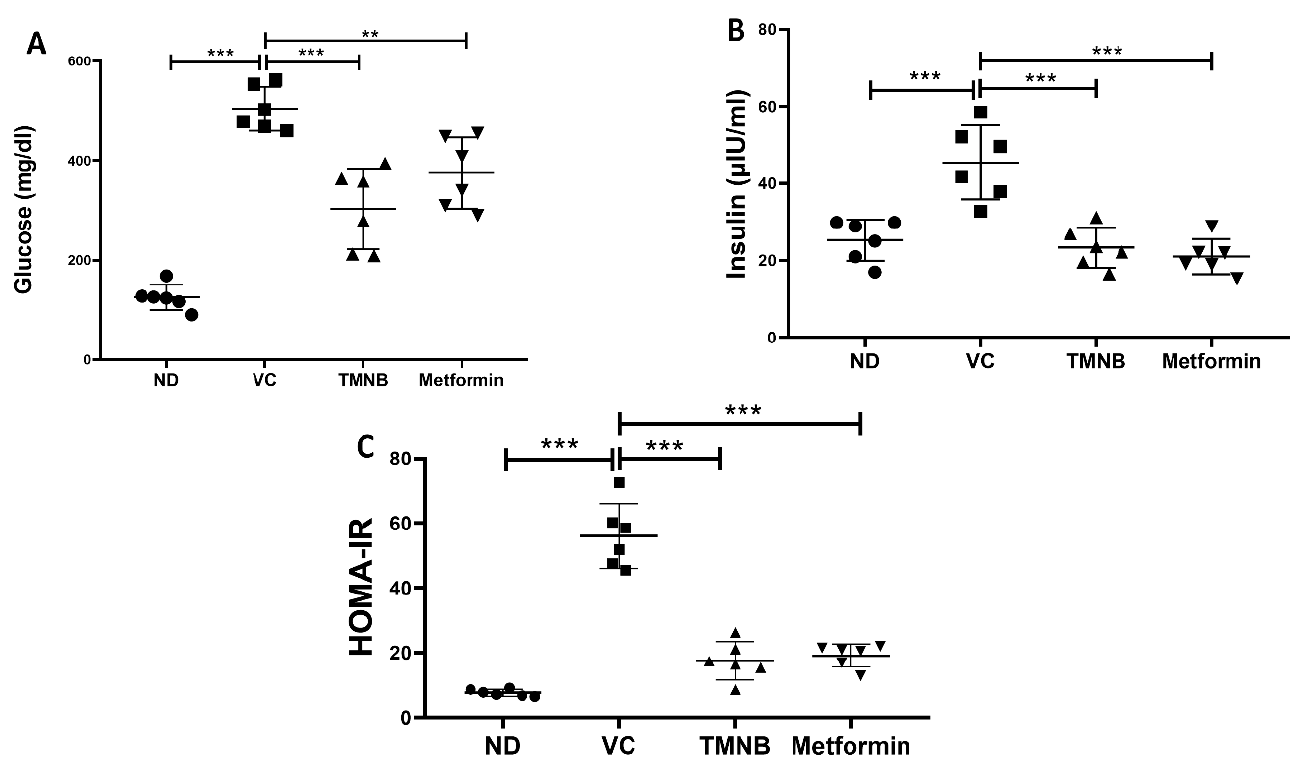
Figure 2. The anti-diabetic effect of 2 ′ ,3,3,5 ′ -tetramethyl-4 ′ -nitro-2 ′ H-1,3 ′ -bipyrazole. TMNB signifi- cantly reduced glucose ( A ) and insulin ( B ) levels in diabetic rats. HOMA-IR ( C ) was significantly reduced with TMNB treatment. Rats were fed HFD for 3 weeks, followed by a single dose of STZ injection (40 mg/kg); and once diabetes was confirmed, rats were treated with 10 mg/kg TMNB or 200 mg/kg metformin for 10 days. After the end of the experiment, serum was collected for ELISA analyses. One-way ANOVA was followed by Tukey post-hoc multiple comparison test, ** < 0.01, *** < 0.001. ND; non-diabetic, VC; vehicle control, TMNB; 2 ′ ,3,3,5 ′ -Tetramethyl-4 ′ -nitro-2 ′ H-1,3 ′ -bipyra- zole.